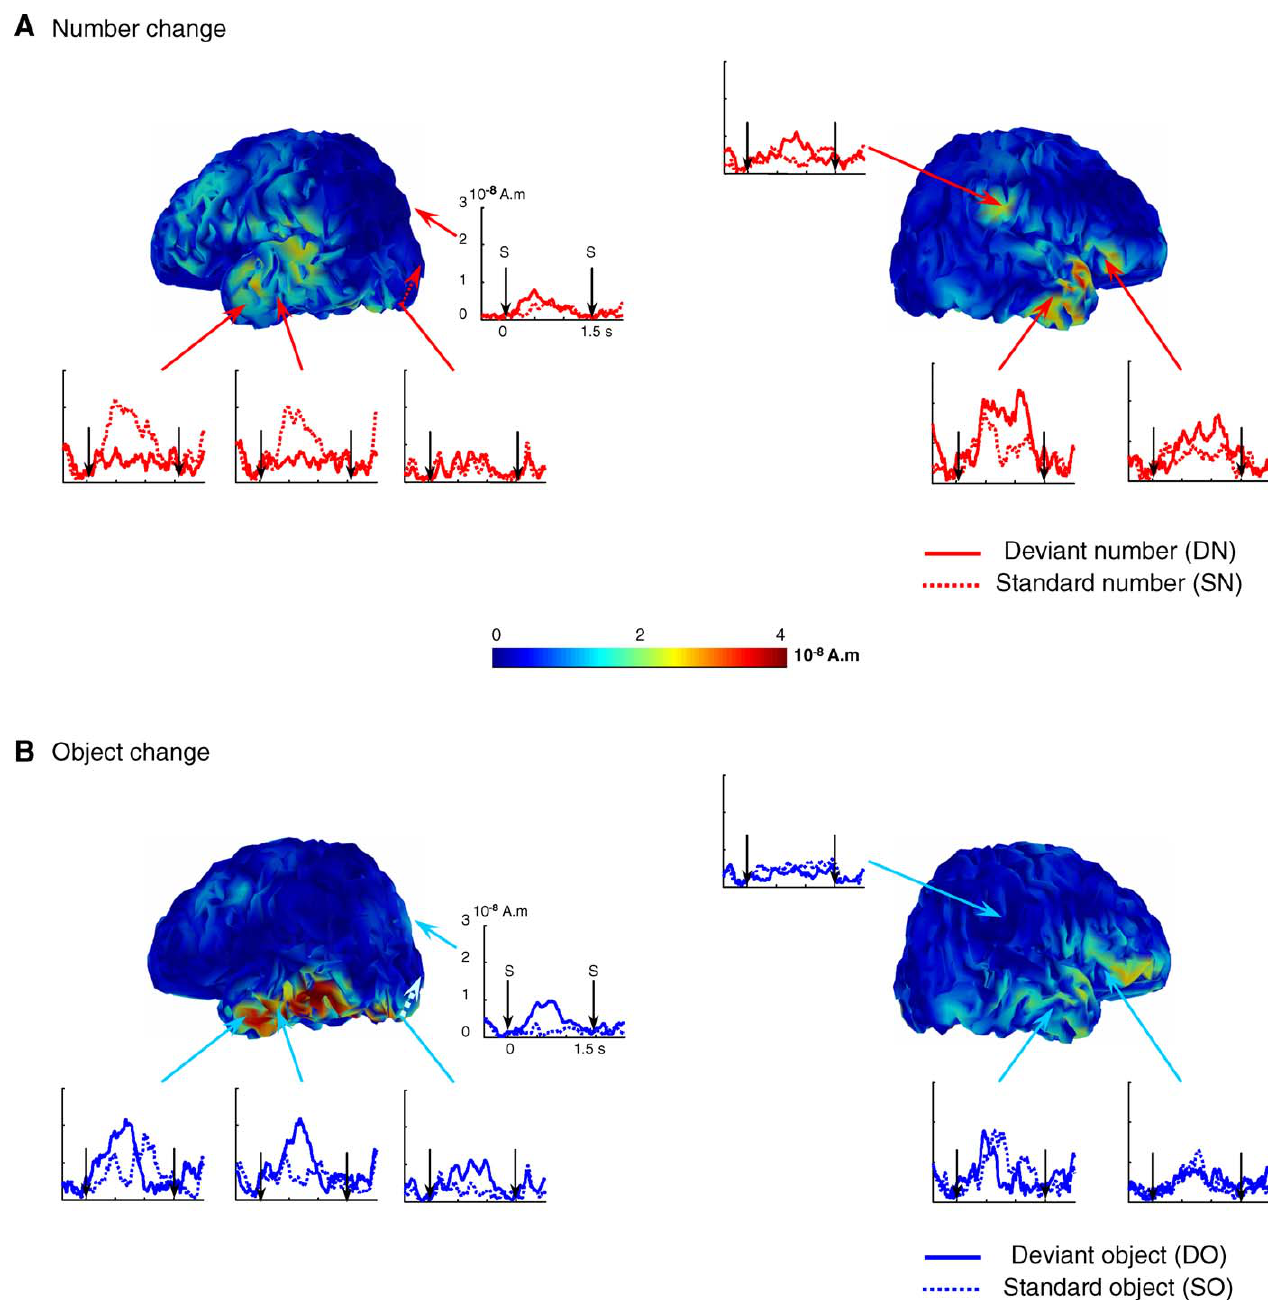
Figure 3. Cortical Source